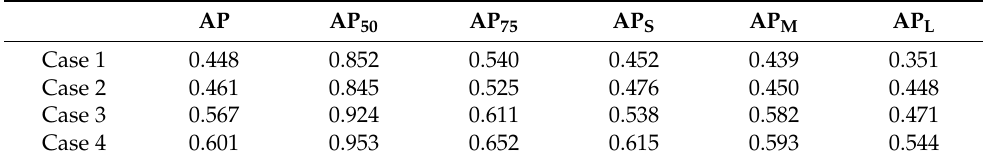
Table 6. The results of four